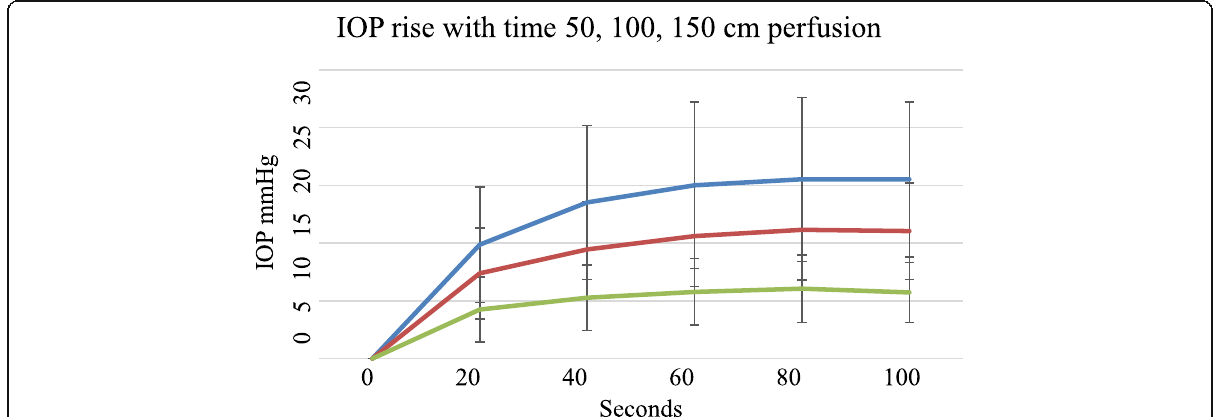
Fig. 2 Rise in IOP with time among 15 subjects at different perfusion pressures, Blue - perfusion at 150 cms, Red – perfusion at 100 cms and Green – perfusion at 50 cms pressure, error bars SD